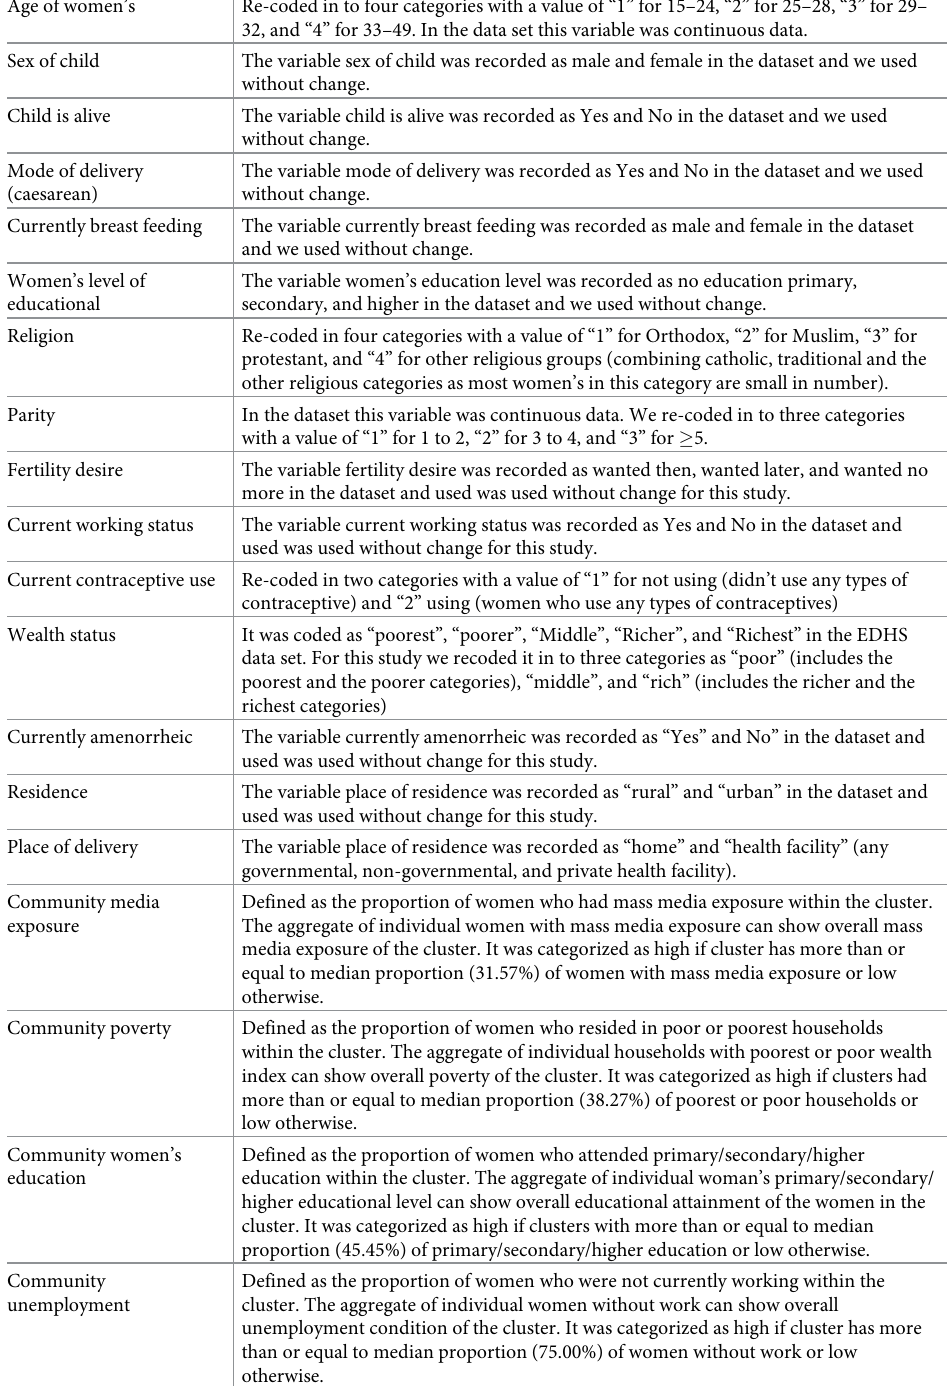
Table 1. Descriptions, and measurements of independent